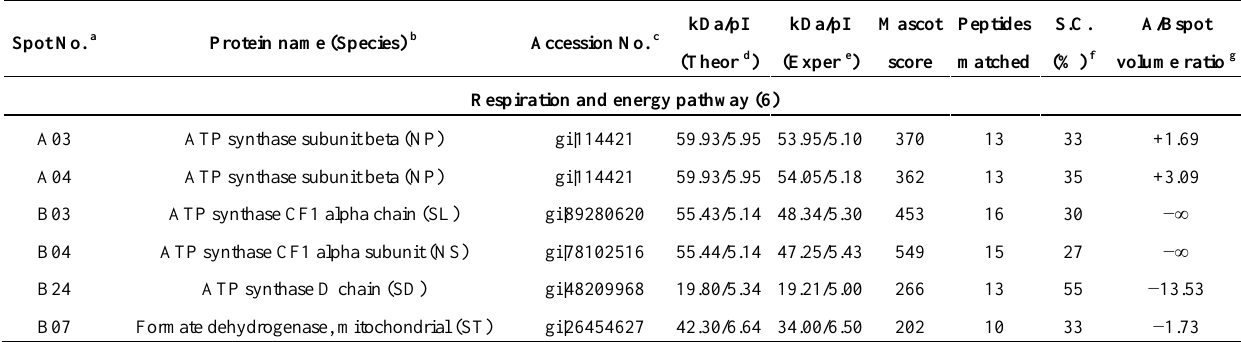
Summary of differentially expressed identified by mass spectrometry